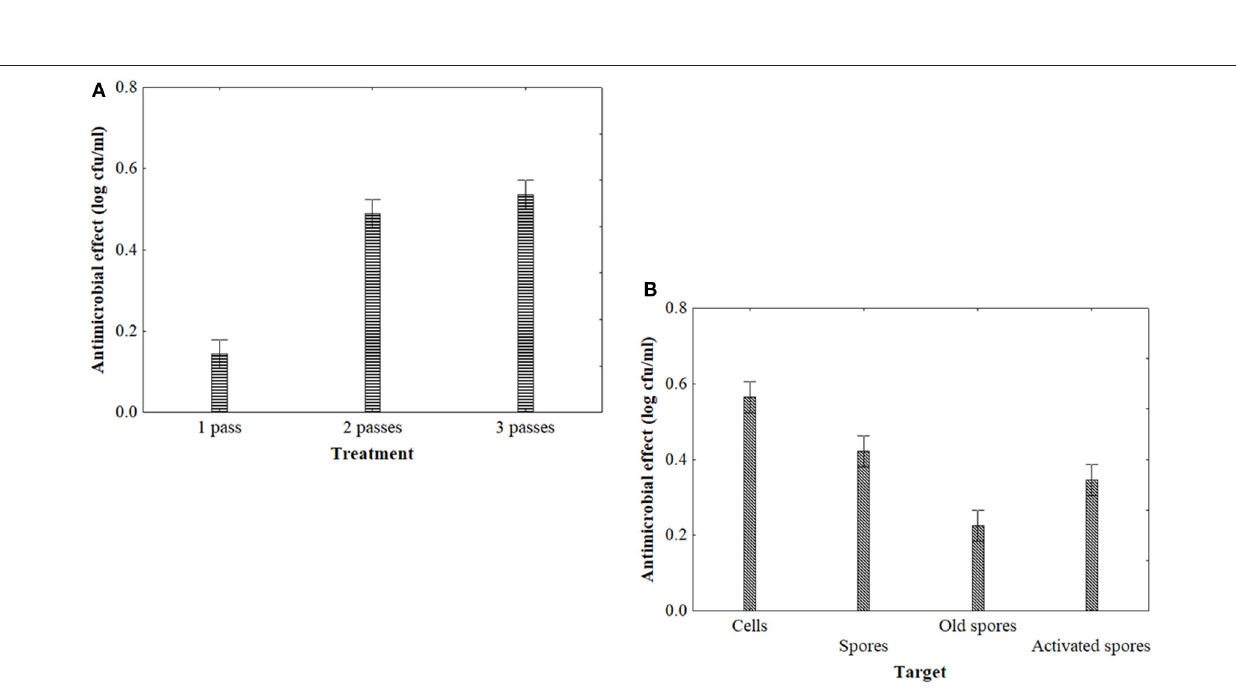
FIGURE 2 | Decomposition of the statistical hypothesis of ANOVA for the effect of homogenization on the antimicrobial effect (reduction of viable count, log cfu/ml) of A. acidoterrestris . Vertical bars denote the 95% confidence intervals. (A) , effect of the treatment (one pass, single treatment at 150 MPa; two and three passes: 2 and 3 treatments at 150 MPa); (B) , effect of